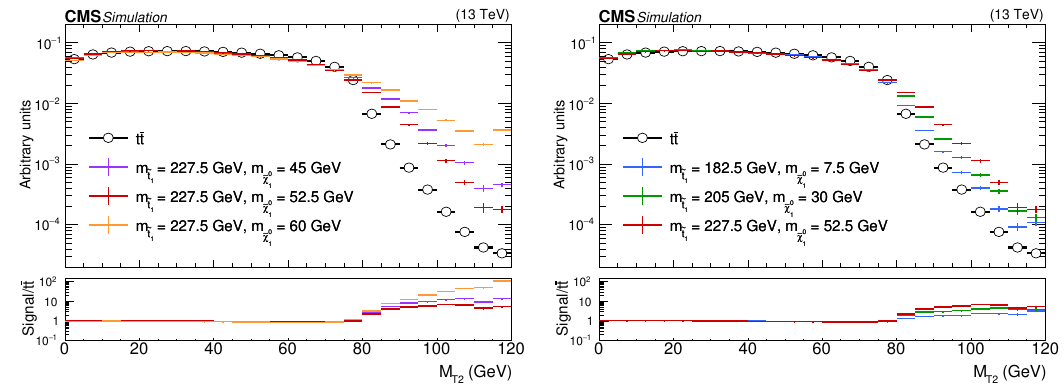
Figure 2 . Normalized M T2 distributions for various mass hypotheses for the top squark and for the neutralino. Variables at the generator level are used for tt and signal events with two generated leptons with p T of at least 20 GeV and j (cid:17) j (cid:20) 2 : 4. The last bin includes the